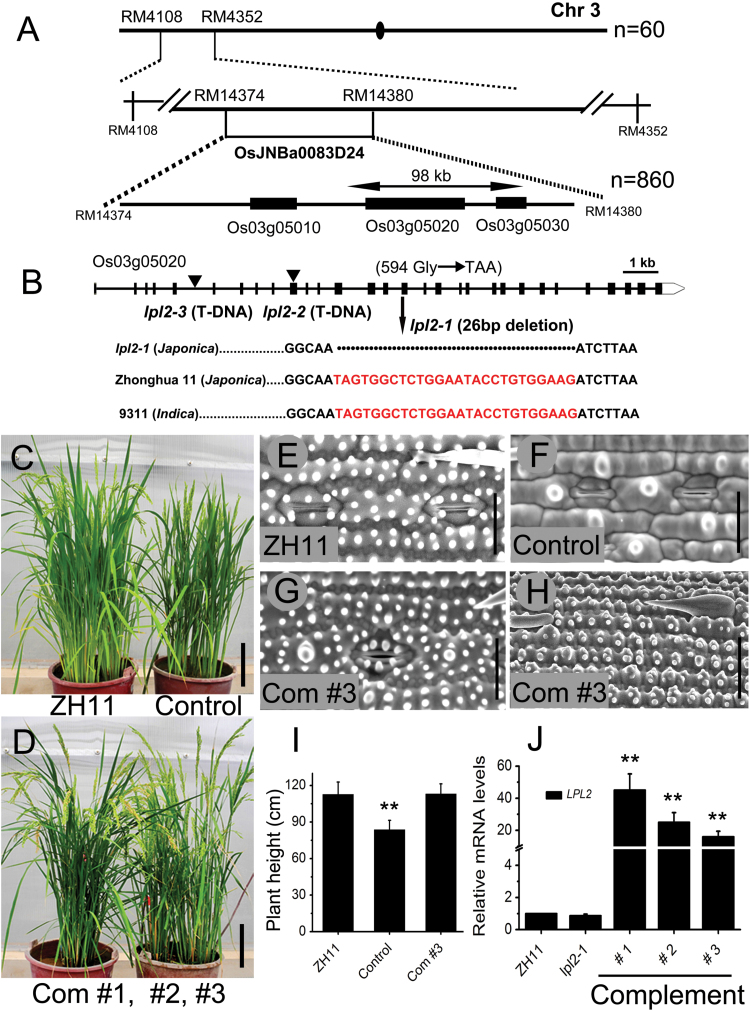
Map-based cloning of LPL2 and complementation test. (A) Fine mapping of the LPL2. LPL2 was localized within BAC clone OsJNBa0083D24 on chromosome 3. N represents sample size. (B) Genomic structure of LPL2. Arrowheads represent T-DNA insertion localization of lpl2-2 and lpl2-3. Vertical arrow shows 26bp deletion of lpl2-1 at the 16th exon. Boxes indicate exons and lines between the boxes indicate introns. (C) ZH11 and control transgenic plants. (D) Plants of three complemented lines (com #1, #2 and #3). Bar, 15cm. SEM images of epidermis on the abaxial leaves of ZH11 (E), control (F), and the com #3 (G). (H) SEM image of stem epidermis in the com #3. Bars, 20 μm. (I) Plant height of ZH11, control and com #3, n=15. (J) Relative mRNA levels of LPL2. The experiment was repeated at least three times. Error bars represent SD; **, P<0.01 (Student’s t-test). (This figure is available in colour at JXB online.)